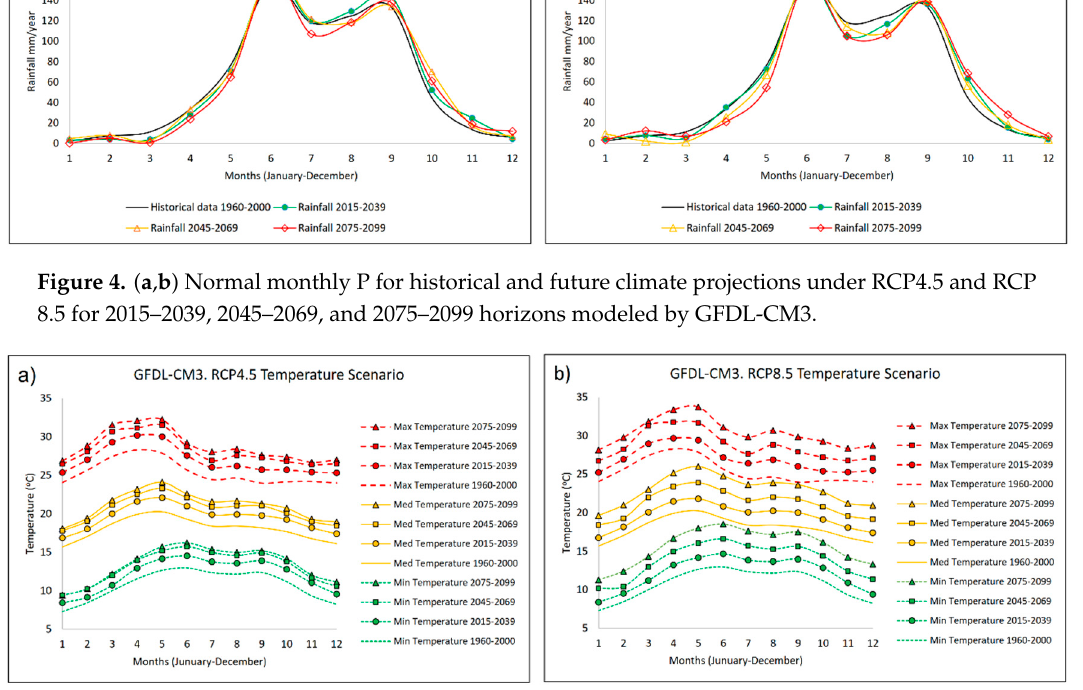
Figure 5. ( a , b ) Normal monthly T for historical and future climate projections under RCP4.5 and RCP